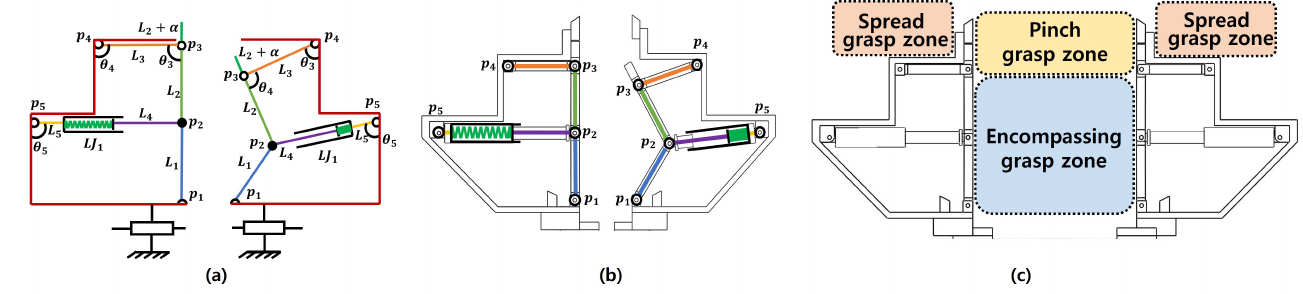
Figure 4. Finger structure of proposed self-adaptive gripper ( a ) Kinematic structure (left: neutral and right: compressed). ( b ) Designed structure (left: neutral and right: compressed). ( c ) Grasping zones by grasping